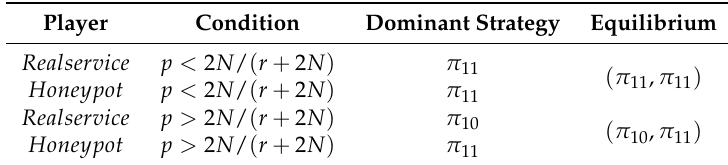
Table 8. List of equilibriums for